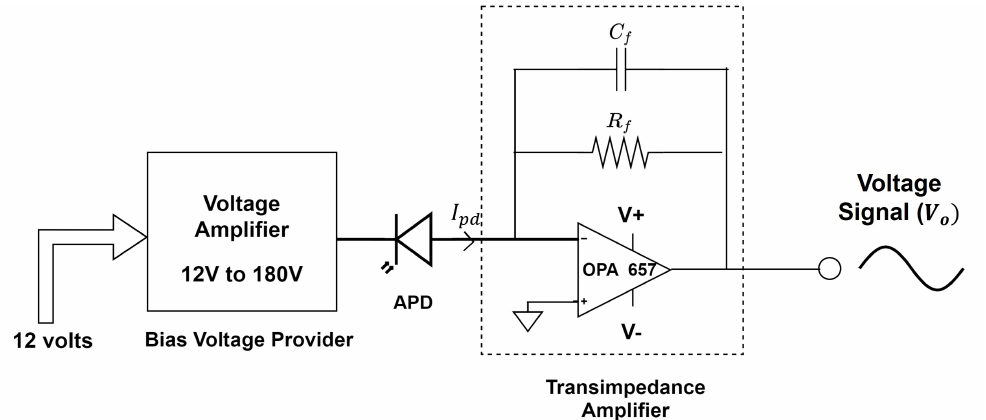
Figure 6. TIA consists of APD (S2384) and OpAmp (OPA 657) to convert the induced photo current to the voltage signal. The APD bias voltage is fed by voltage amplifier integrated to the TIA circuit. A 1 M Ω resistor and 0.1 pF capacitor are used for feedback resistance R f and feedback capacitance C f ,